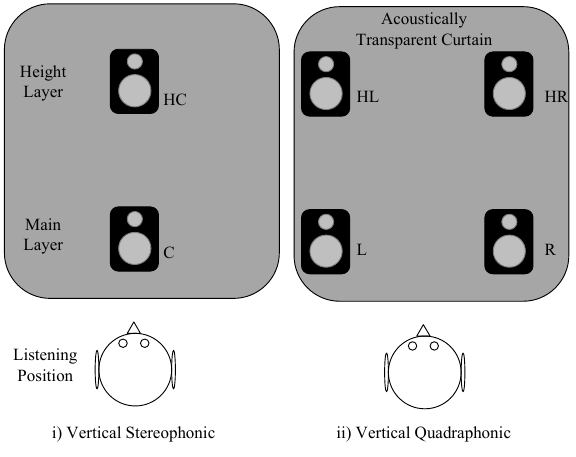
Figure 3. Presentation methods for test stimuli.